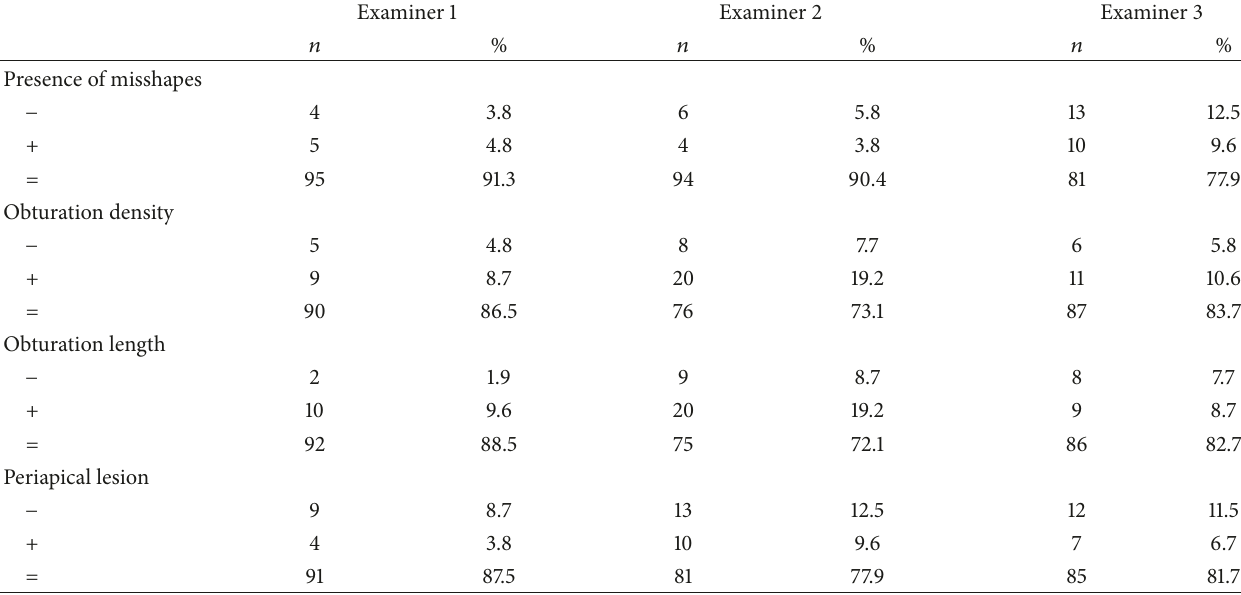
Table 1: Evaluation scores comparing digital images to conventional radiographs by